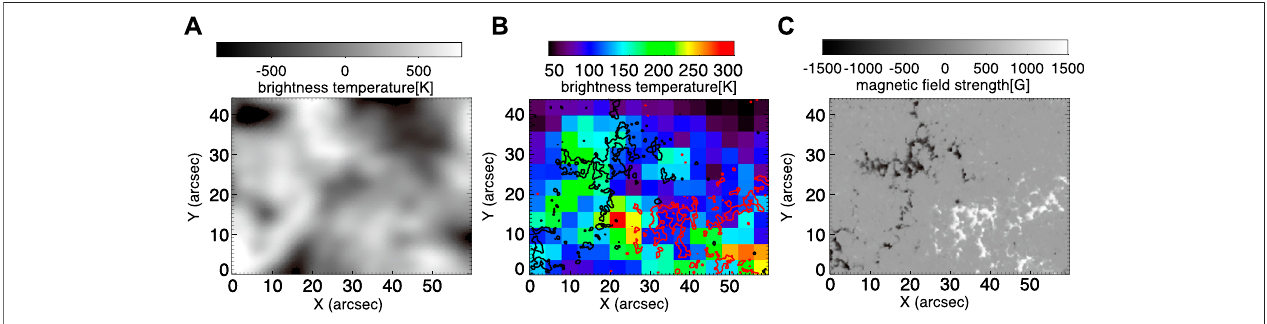
FIGURE1| Thespatial distribution of (A) themeanbrightnesstemperature and (B) the standarddeviationinthe time series ofALMA data. Thecontours represent the spatial distribution of (C) magnetic fl ux density: positive 300 gauss in red and negative 300 gauss in